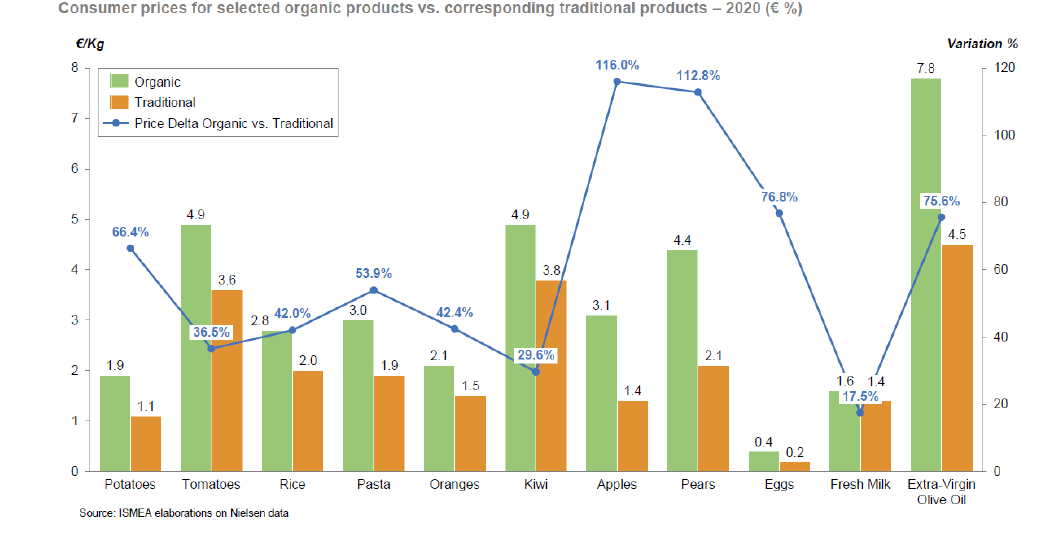
Figure 6: Price Delta & Willingness to Pay More (Nielsen Global